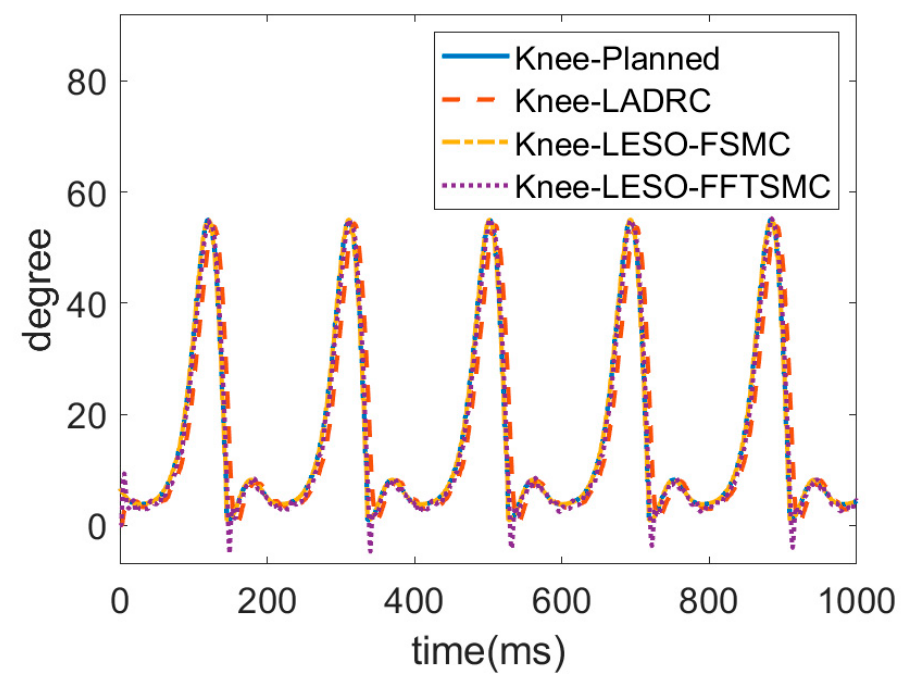
Figure 9. Trajectories of knee joint for proposed LESO-based controllers.